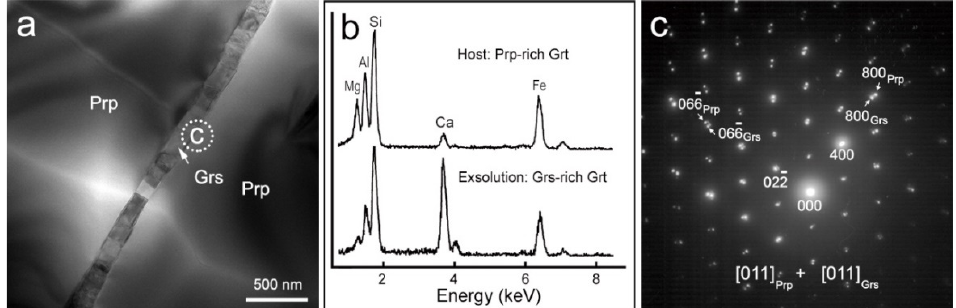
Figure 4. TEM images of Grs-rich exsolutions precipitated at the subgrain boundary of Prp-rich host. ( a ) Exsolution precipitated at the subgrain boundary of host. ( b ) EDS spectra of the exsolved lamellae and host in ( a ) show that they are grossular-rich (Grs) and pyrope-rich (Prp) garnet, respectively. ( c ) SAED pattern obtained from the areas marked in ( a ) shows this Grs-rich lamella bearing the same crystallographic orientation with Prp-rich host.